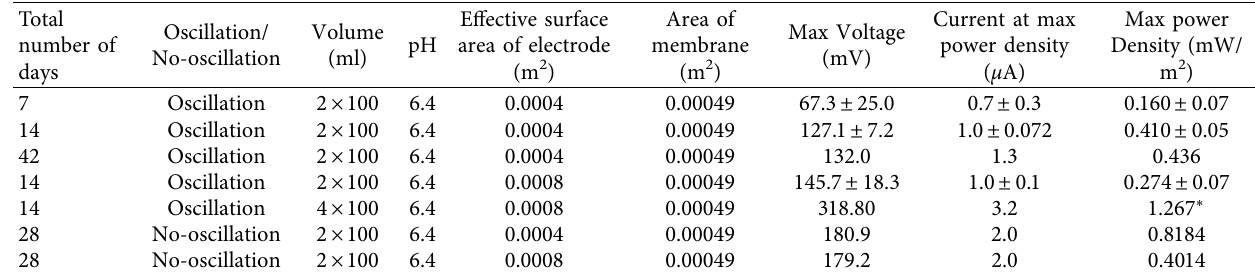
∗ Max power density was calculated from the two dual-chambered stacked series MFC units containing an electrode size of 10cm 2